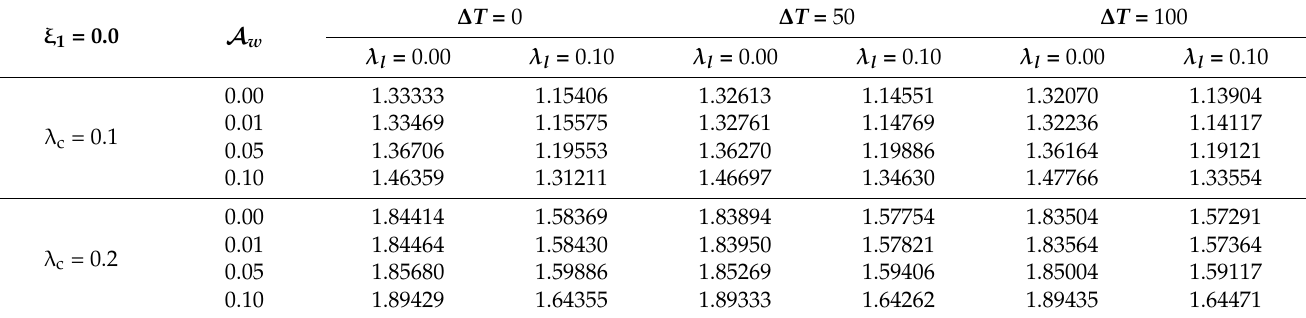
Table 9. Nonlinear dimensionless natural frequencies of porous FG clamped–clamped (C–C) nano- beam for ξ 1 = 0.0 in the case of First-Order Hamiltonian Approach.